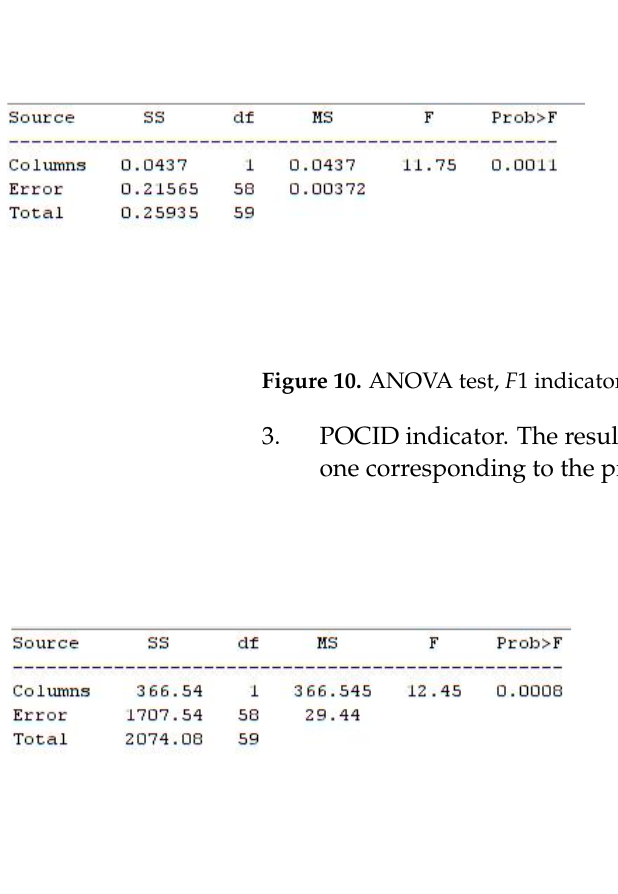
Figure 11. ANOVA test, POCID indicator.